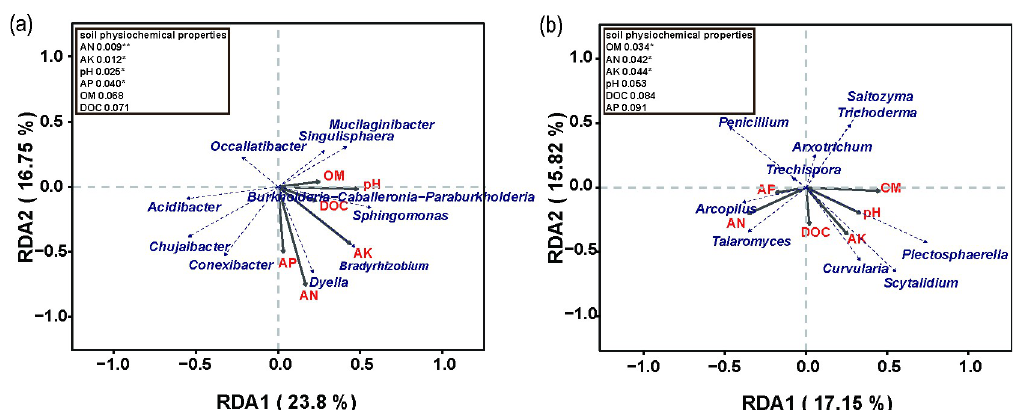
Fig 5. Redundancy analysis (RDA) indicating shift in bacterial (a) and fungal (b) communities caused by soil physiochemical properties. AN, available nitrogen; AP, available phosphorus; AK, available potassium; OM, organic matter; DOC, Dissolved organic carbon; In the top-left, the soil properties were fitted to the ordination plots using 999 permutations test (P-values) � 0.01 < p < 0.05, �� 0.001 < p < 0.01; CK: N, P, and K fertilizer; WS1: water soluble fertilizer 1,050 kg/hm 2 ; WS2: water soluble fertilizer 1,650 kg/hm 2